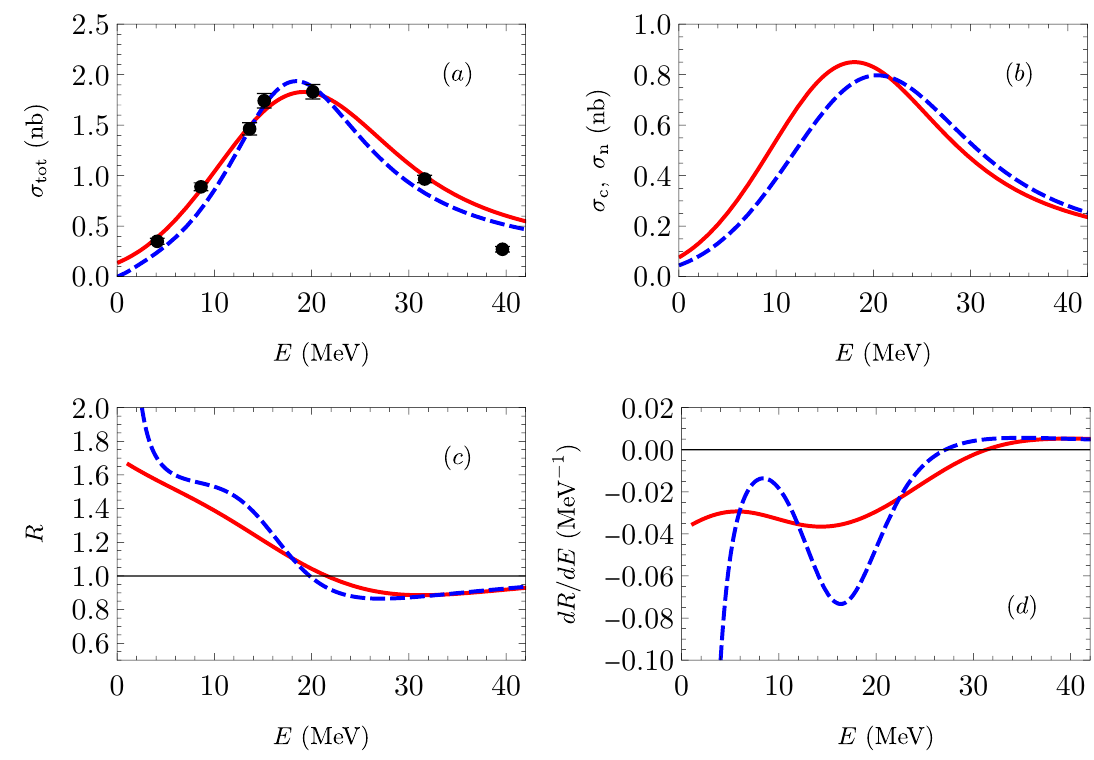
Figure 2 . Cross sections of B ¯ B meson production for a = 2 . 5 fm, V 0 = 269 MeV. (a) Energy dependence of σ tot = σ c + σ n with (solid curve) and without (dashed curve) averaging over the beam energy spread. (b) Energy dependence of σ c (solid curve) and σ n (dashed curve) with averaging over the beam energy spread. (c) Energy dependence of R = σ c /σ n with (solid curve) and without (dashed curve) averaging over the beam energy spread. (d) Energy dependence of dR/dE with (solid curve) and without (dashed curve) averaging over the beam energy spread. Experimental data with the radiative corrections taken into account are from ref.